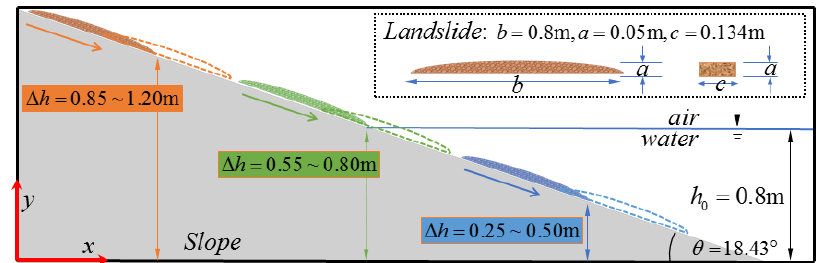
Figure 5. Setting diagram of the cases of falling height under different submergence conditions.